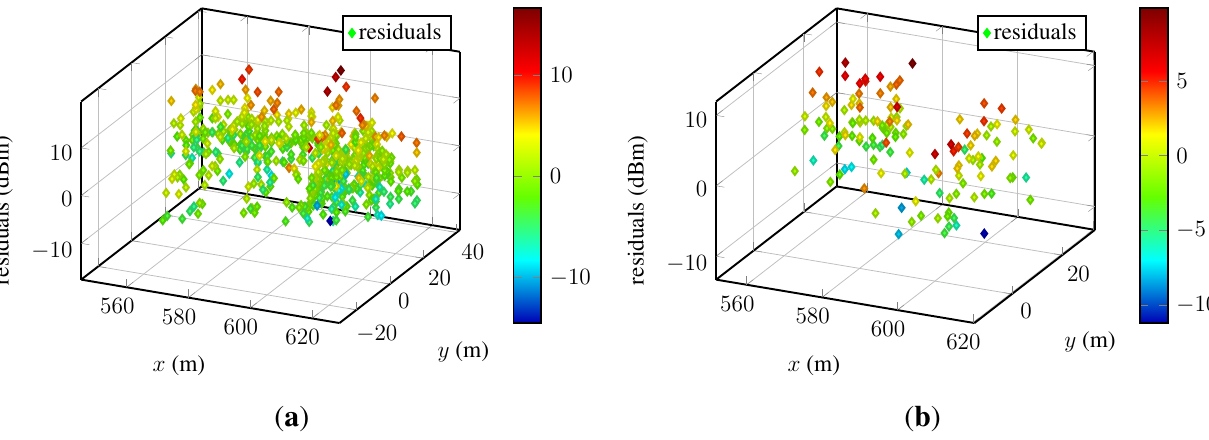
Figure 6. Residuals plotted against space for two different access points: ( a ) An access point with many fingerprints; ( b ) an access point with few fingerprints. The magnitude of the residuals are indicated by the color